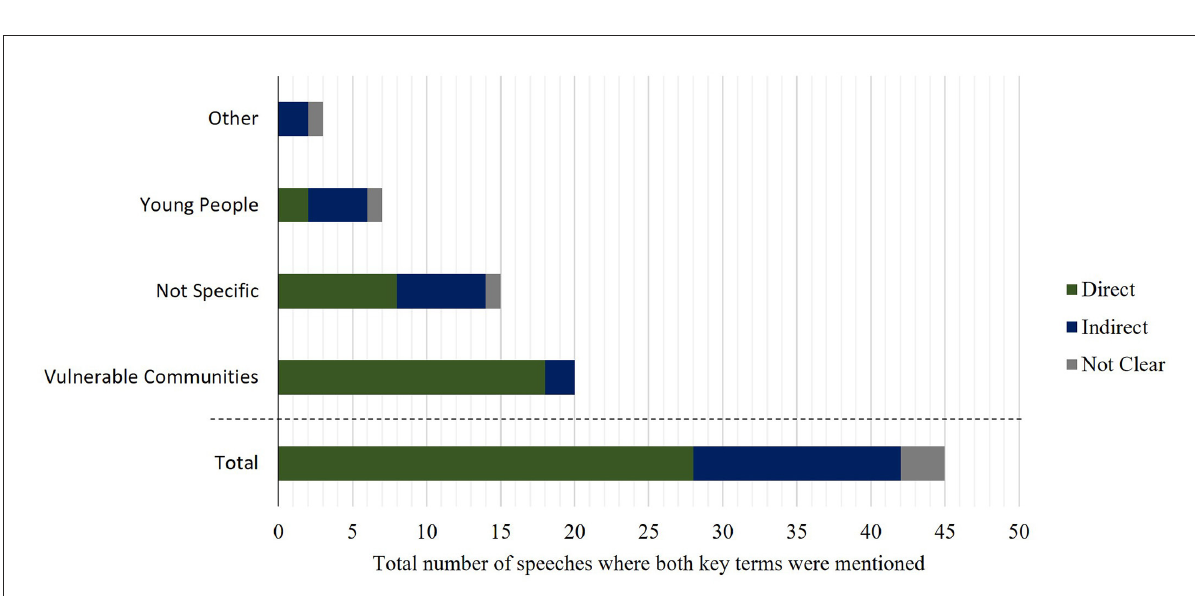
FIGURE6 The number of speeches in which specific populations are mentioned in relation to climate change, split by whether the identified impact on the population was direct or indirect. Direct effects are defined as those where an individual experiences the effects of climate change first-hand. Indirect effects include the individual not directly experiencing the effects of climate change but being affected by knowledge of the issues. The “other” population category includes for example “those concerned by the environment”, farmers and other politicians. Some speeches mentioned more than one group. The analysis includes only speeches where direct links between mental health and climate change were mentioned, for the period between 01/01/2001 and 31/12/2020 ( N =